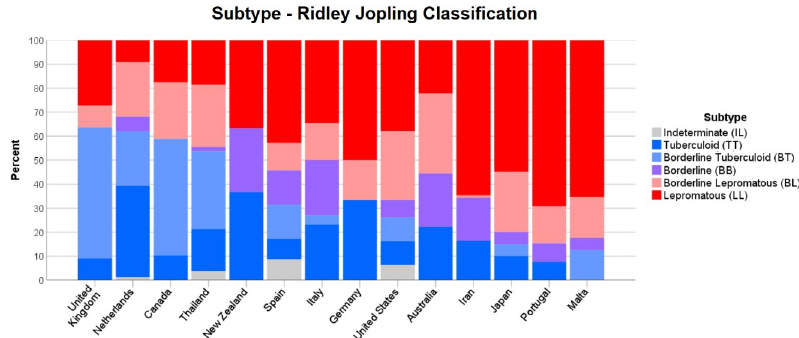
Fig 5. Leprosy subtype per country using the Ridley Jopling classification